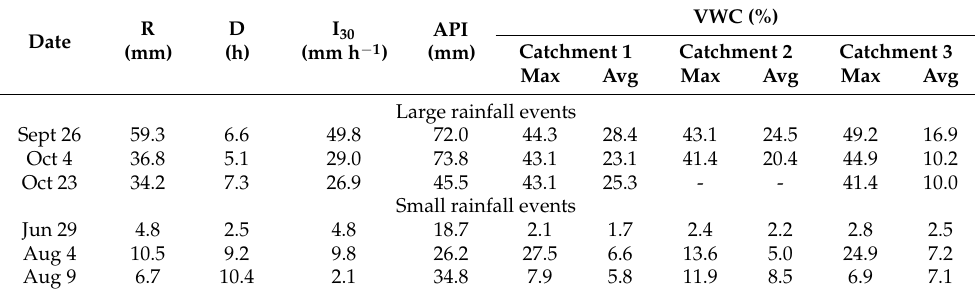
Table 3. Precipitation metrics and volumetric water content for three large rainfall events (>30 mm) and three small rainfall events (<10 mm) before thinning (2018).